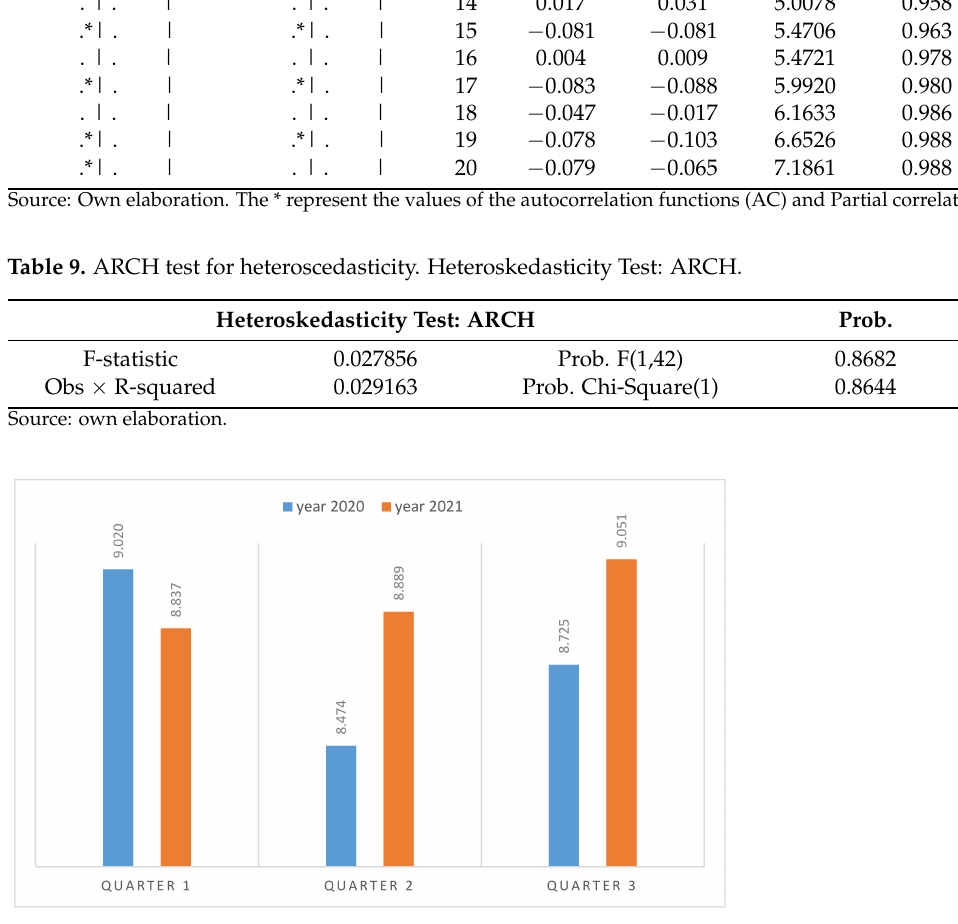
Figure 7. Prediction of the of female labor market (thousands of women) and its comparison with 2020). Source: own